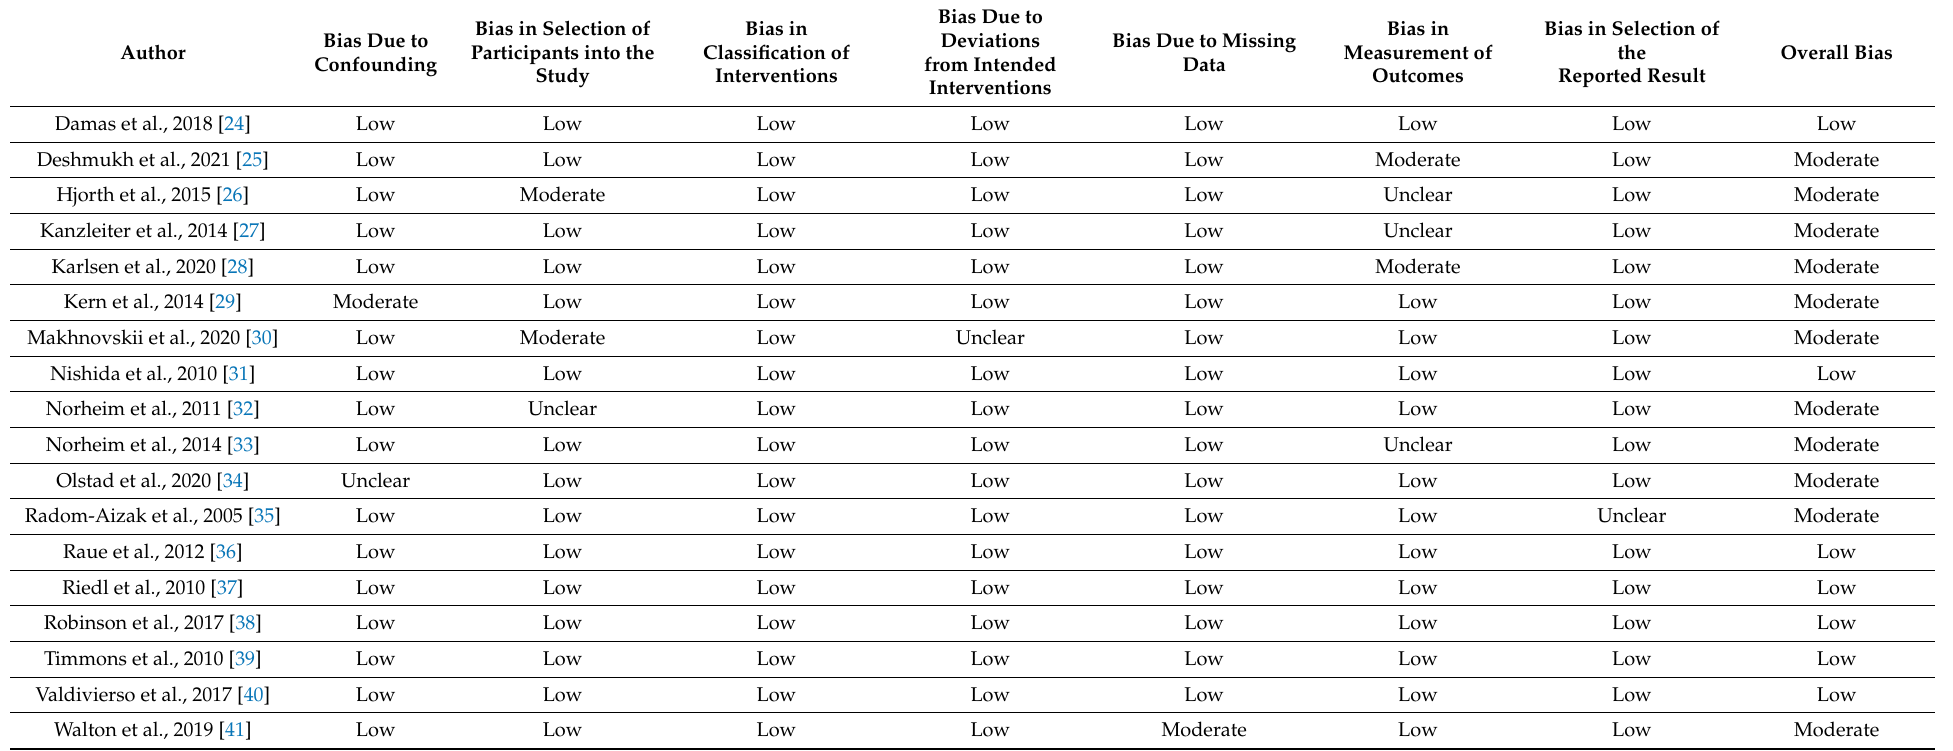
Table 1. ROBINS-I quality assessment scores for the non-RCTs included studies.